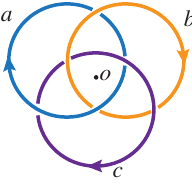
FIG. 16. The configuration of three mutually linked strings. This configuration is topologically equivalent to the configura- tion shown in Fig. 15(c) but is deformed to a shape with threefold rotation symmetry according to an axis perpendicular to the plane at the point o